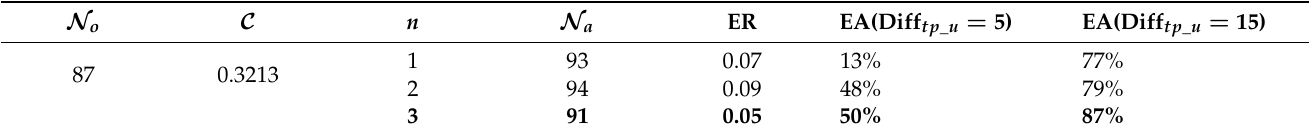
Table 5. Estimation results for data set